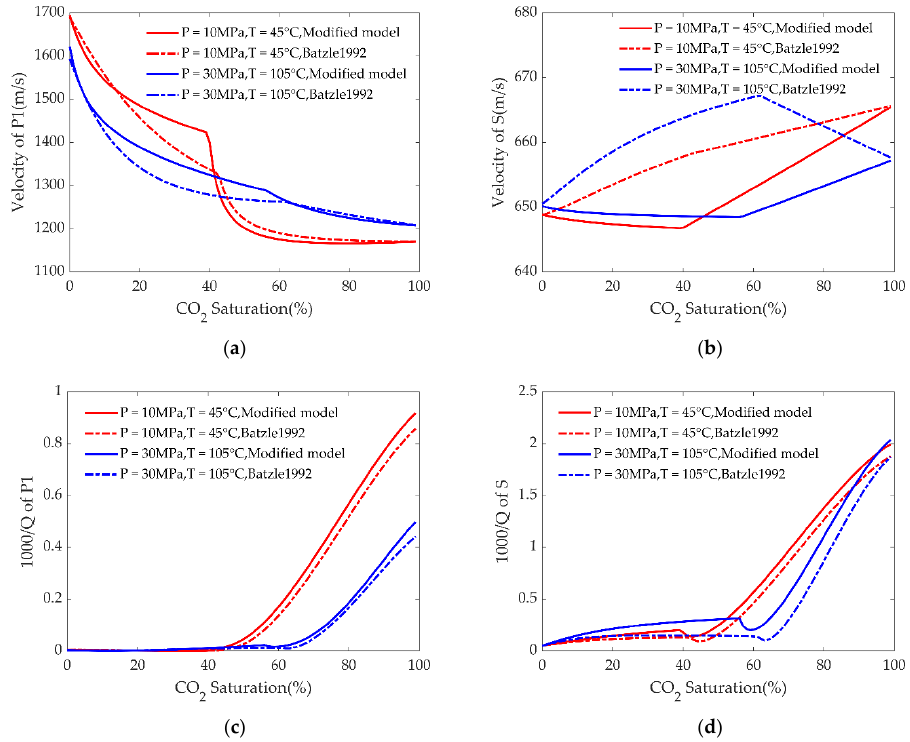
Figure 10. Effects of fluid parameter model on the phase velocities and attenuations of waves: ( a ) P1 velocity; ( b ) S velocity; ( c ) P1 attenuation; ( d ) S attenuation.